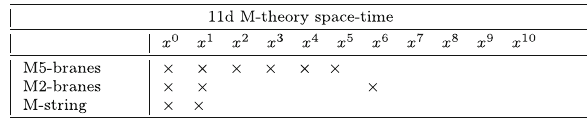
Fig. 1 Coordinates of the 11d M-theory space-time